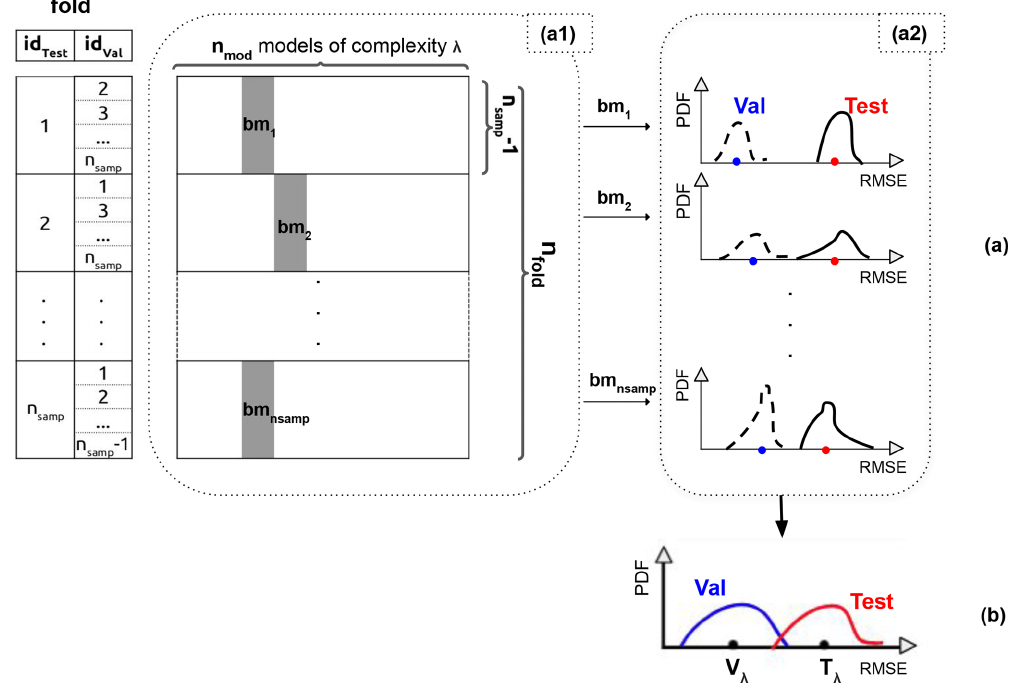
Figure 3. Illustration of the LTO procedure to estimate a model quality for a fixed complexity level λ with n mod candidate models (horizontal axis). (a) The model errors obtained for each candidate model and each fold of the database B (vertical axes). (b) The obtained RMSE values for the validation and testing datasets. (See detailed description in Sect. 3.2.)